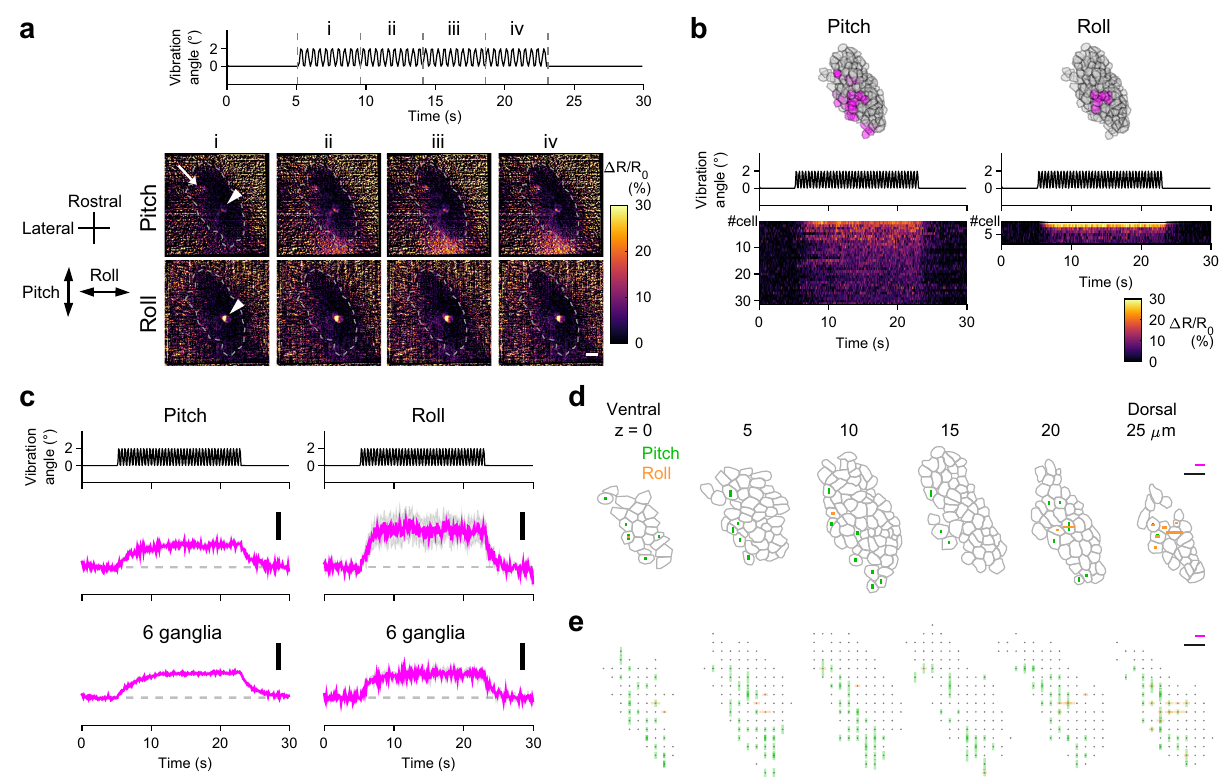
Fig.6|AsubpopulationofVGNsrelayheadvibrationsignals.a Example ofVGN responses to head vibration in pitch/roll axis (see Supplementary Movie 6). Vibration time course (top). Sequential images showing changes of mean Δ R / R 0 during the time period “ i ” to “ iv ” from those during the pre-stimulus period (time 0to5s)(bottom).MaximumintensityprojectionofVGNsintherostraldivisionof VG spanning a depth of 25 μ m in a Tg(myo6b:jGCaMP7f; myo6b:tdTomato) larva imaged from ventral at 5 dpf. One neuron responds to both stimuli (arrowheads) whereas another responds to only pitch vibration (arrow). Dashed lines: VG contours. Scale bar: 10 μ m. b Example of vibration responses per VGN. The same ganglionshownin( a ).Responsestopitch(left)androll(right)vibration.Location